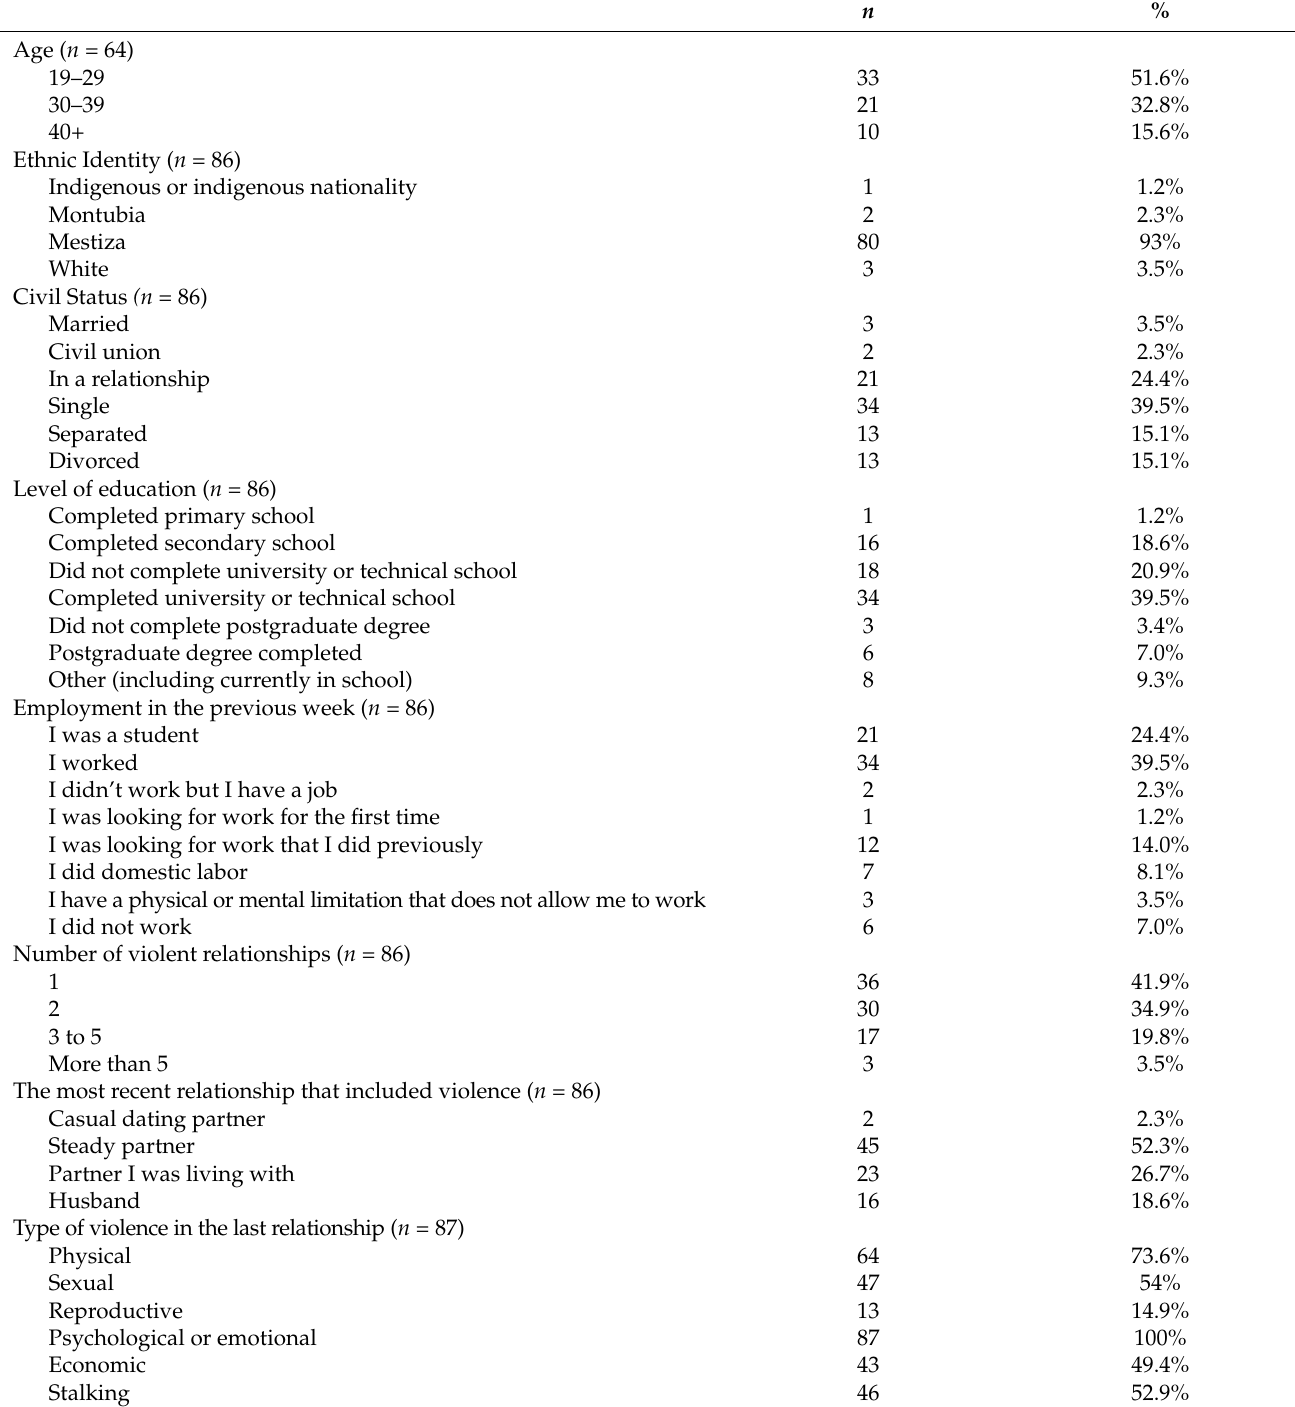
Table 1. Demographic Characteristics ( n =